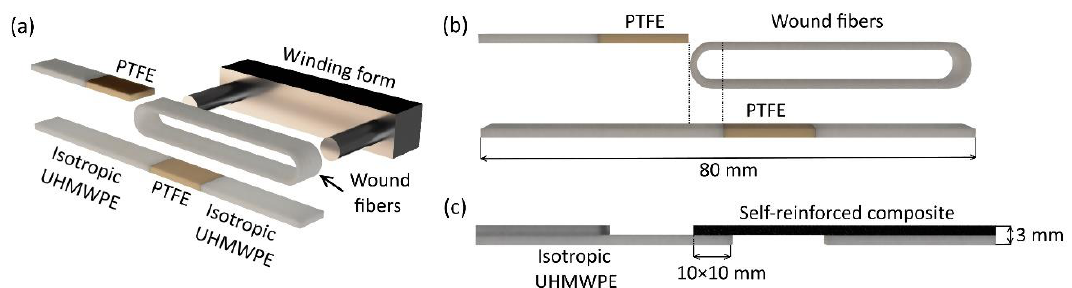
Figure 1. Scheme of obtaining the hybrid composite material based on ultra-high molecular weight polyethylene (UHMWPE) for the single-lap shear tests. The winding of initial UHMWPE fibers ( a ) and parts of hybrid composite material before ( b ) and after ( c ) hot compaction.